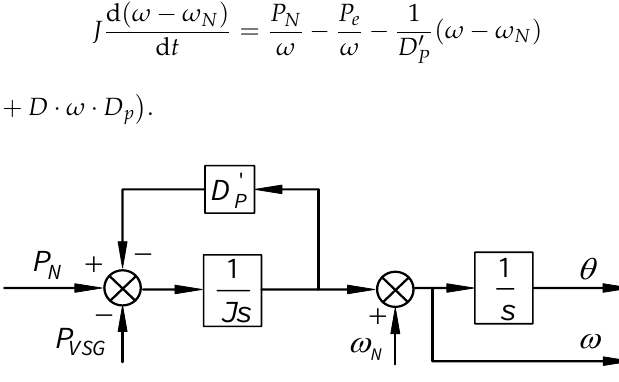
Figure 3. Simplified active power controller of VSG.